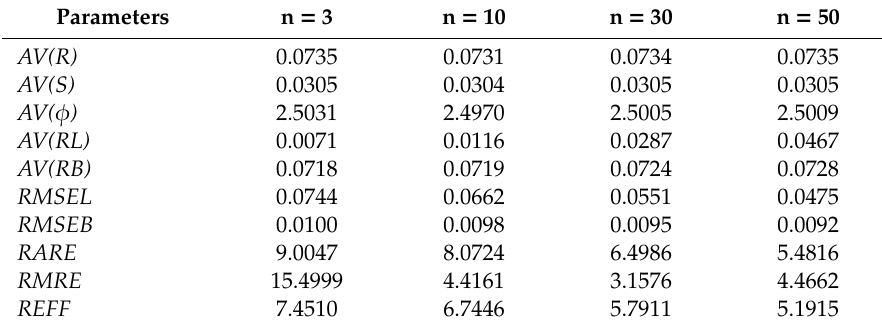
Table 6. Simulation results for cases A’22.